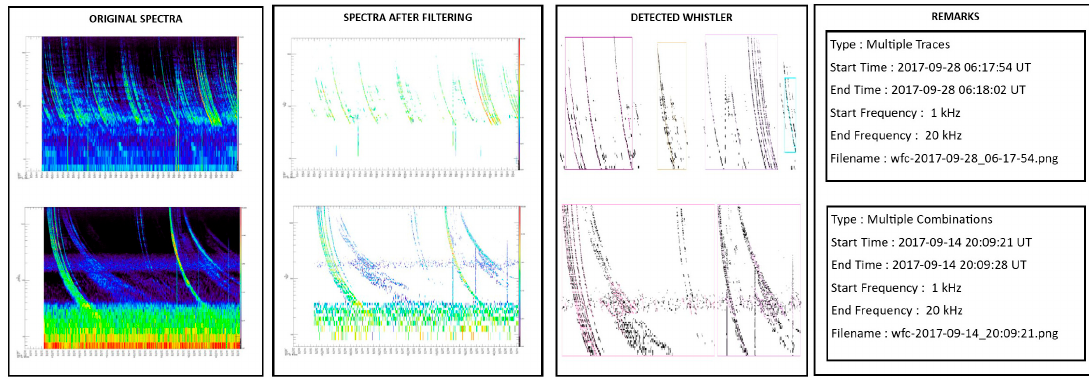
Figure 11. The detected multiple-traces and multiple-combinations whistler